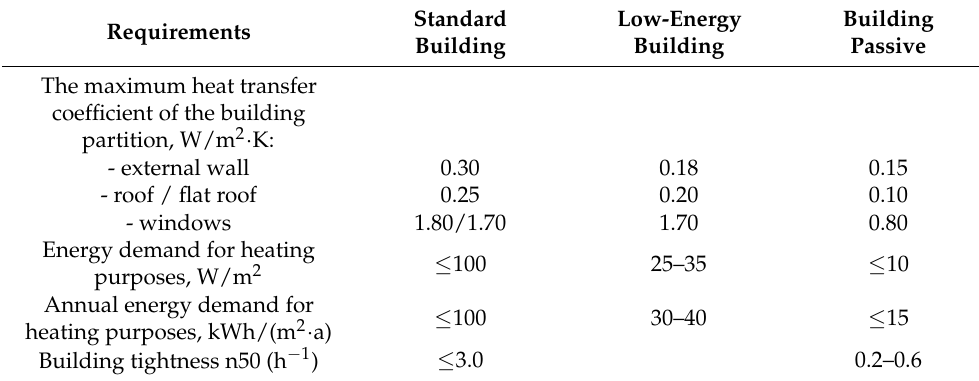
Table 1. Criteria and standards for residential buildings — a list of parameters.